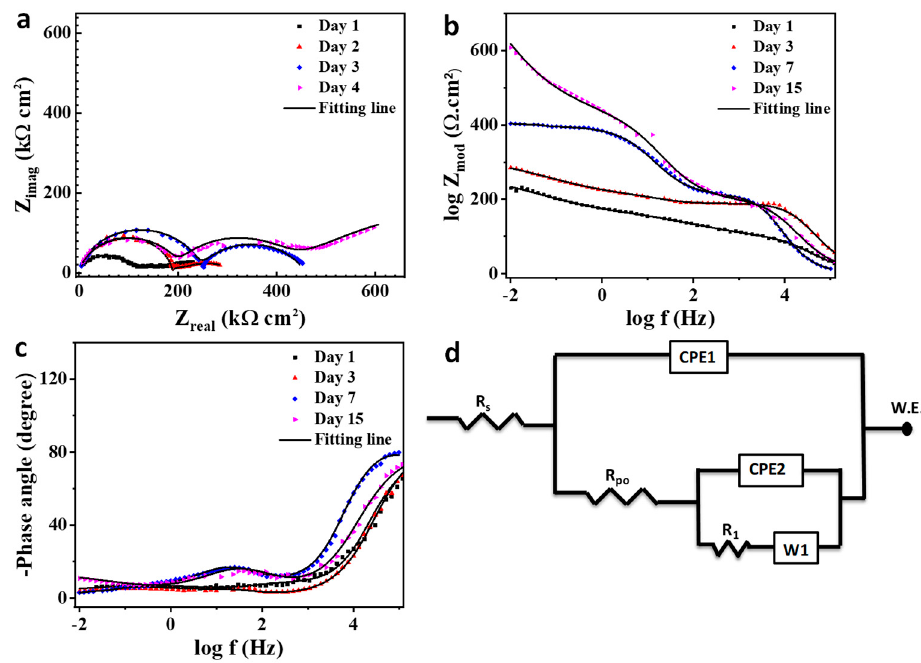
Figure 12. Electrochemical impedance curves for scratched plain coating immersed in 3.5 wt% NaCl for different exposure times where ( a ) Nyquist plot, ( b ) bode plot, ( c ) phase angle plot, and ( d ) the applicable equivalent circuit for the data fitting.